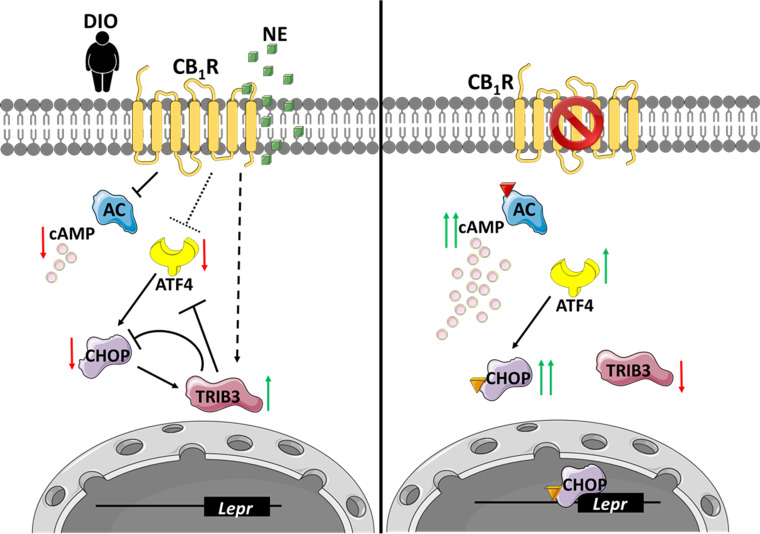
An illustration that describes the suggested molecular mechanism involving CB1R and C/EBP homologous protein (CHOP) in the regulation of soluble isoform of leptin receptor (sOb-R) levels.(Left) When overexpressed in the liver, activated by endocannabinoids during diet-induced obesity (DIO) or synthetic cannabinoids, such as noladin ether (NE, green squares), CB1R attenuates cAMP (pink circles) production by inhibiting adenylate cyclase (AC). CB1R also represses the expression of ATF4, as well as upregulates Trib3 expression. As a consequence, CHOP levels are reduced, transcribing less Lepr. (Right) Blocking CB1R in hepatocytes reverses these changes, leading to the activation and translocation of CHOP to the nucleus, which, in turn, directly binds the Lepr promoter and promotes the expression of sOb-R. Red arrows represent downregulation, whereas green arrows represent upregulation. Colored triangles represent activation.